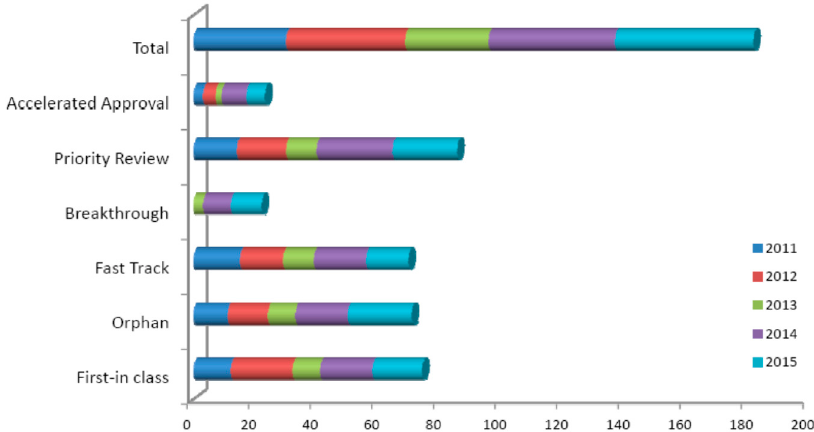
Figure 5. Innovative NMEs approved in 2011–2015. CDER used a number of regulatory methods including Fast Track, Breakthrough, Priority Review, and Accelerated Approval to expedite innovative NMEs to market.